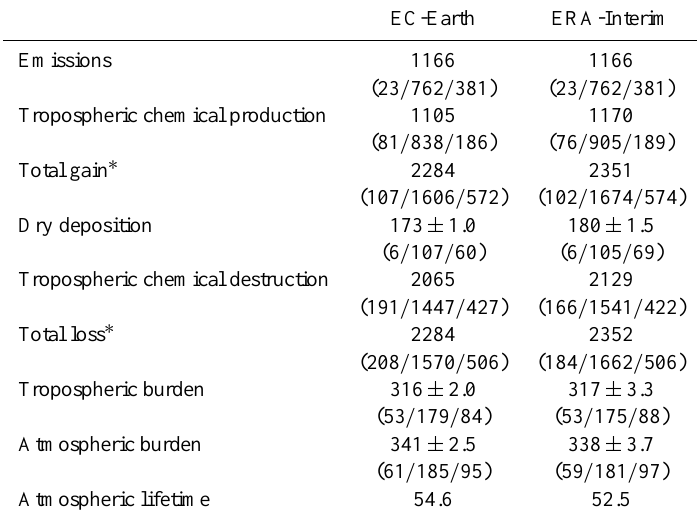
Table 4. Contributions to the budget of CO in the atmosphere (TgCOyear − 1 ) , together with the tropospheric and atmospheric burdens of CO (TgCO), and the atmospheric lifetime of CO (days) for the reference EC-Earth simulation and the corresponding ERA-Interim simulation. The contributions from 90–30 ◦ S, 30 ◦ S–30 ◦ N, and 30–90 ◦ N are given by the numbers between parentheses. Results have been obtained from a monthly analysis with a fixed tropopause level, set to the uppermost model layer for which the monthly mean O 3 mixing ratio is below 150ppbv. Standard deviations are based on the simulated interannual